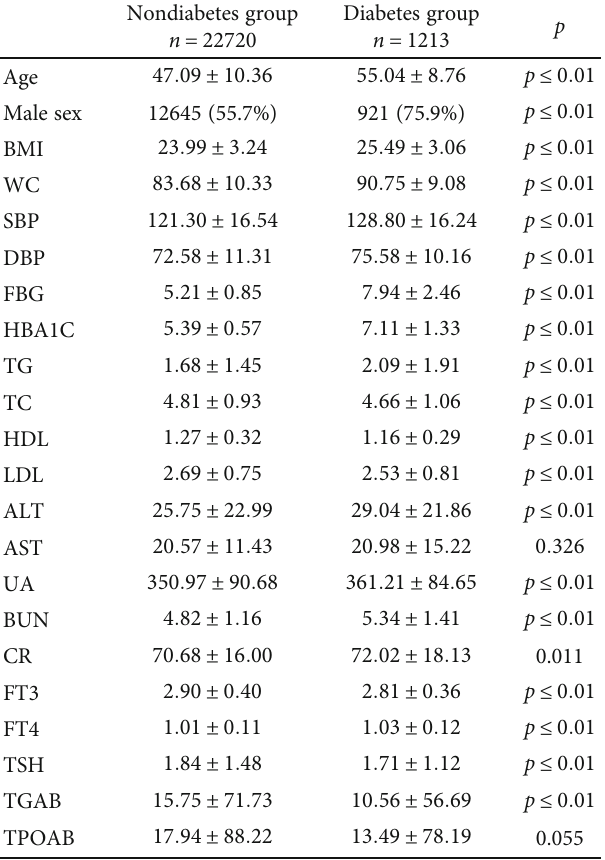
Table 2: Comparison of baseline data between diabetes group and nondiabetes